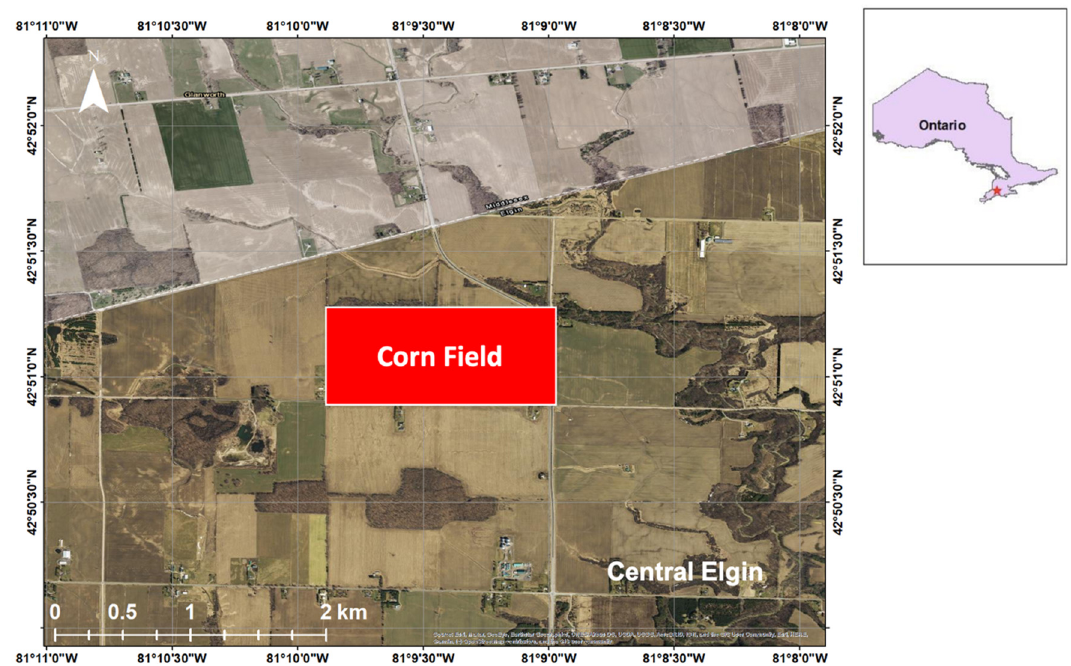
Figure 1. Location of the corn field in Central Elgin, Ontario, Canada, over a Google Earth image.